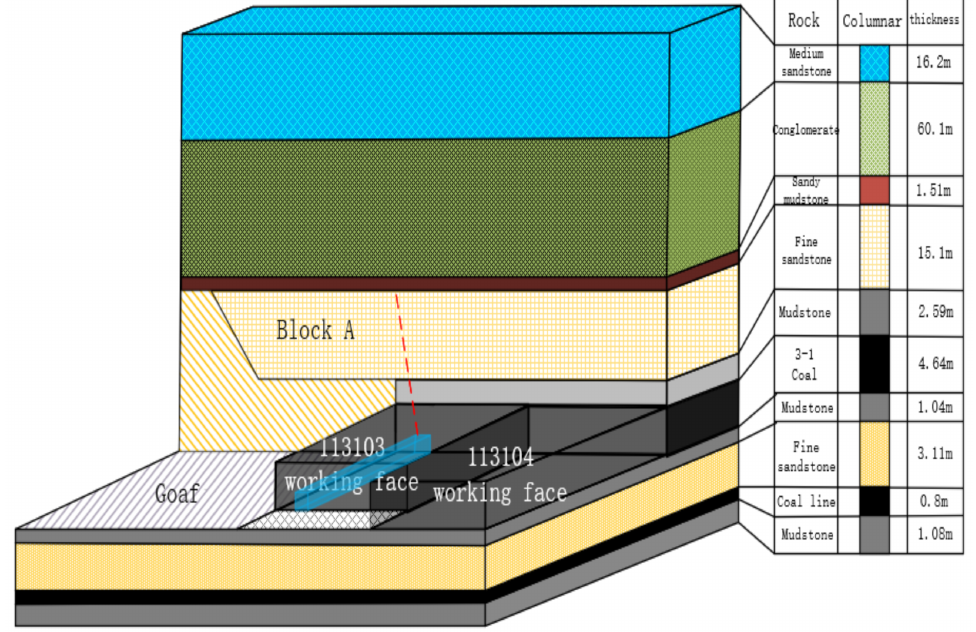
Figure 1. Column chart of roof